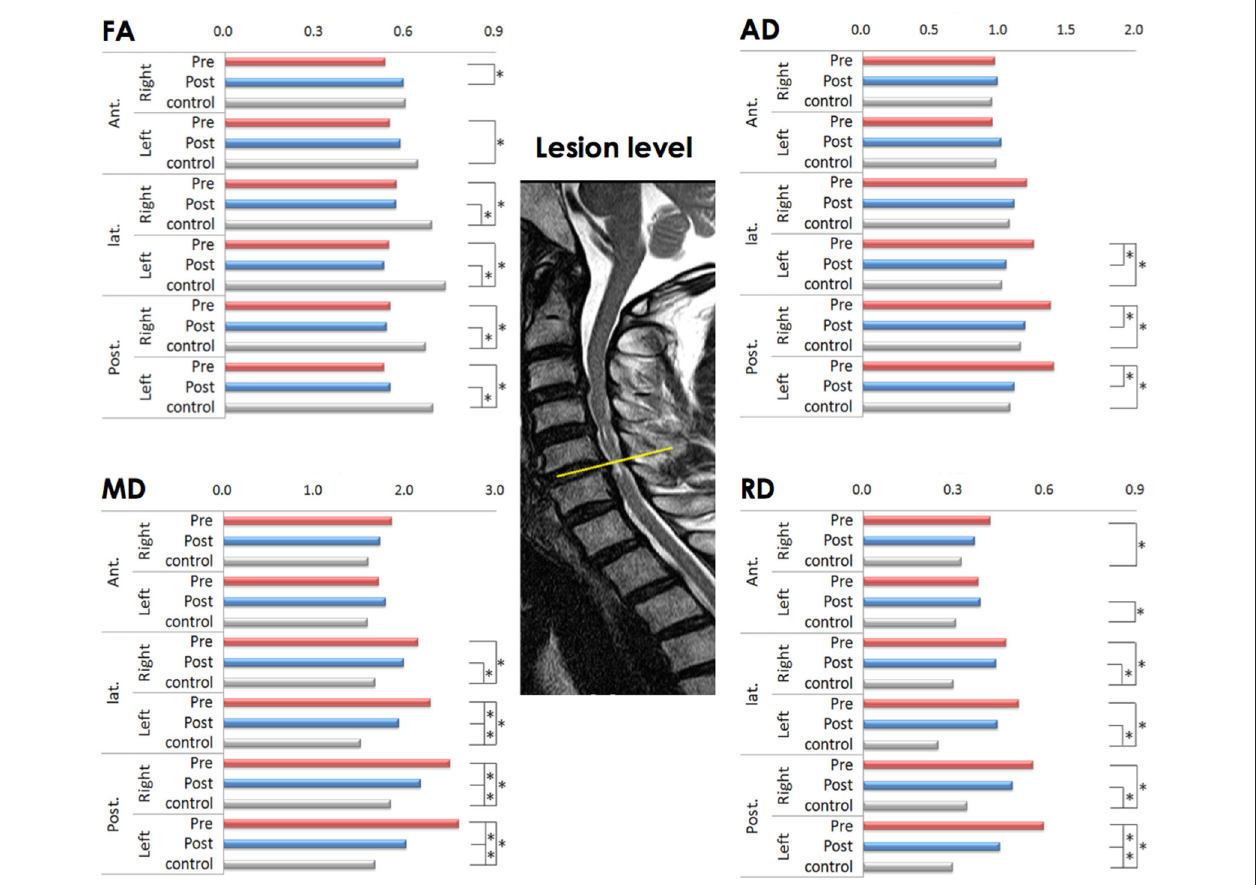
FIGURE 1 | Comparison of diffusion metrics at six regions of interest (ROIs) at the lesion level before and after laminoplasty (matched with healthy controls). FA (fractional anisotropy), MD (mean diffusivity), AD (axial diffusivity), and RD (radial diffusivity) values; * p < 0.001 is considered to be statistically significant; the yellow line indicates the lesion